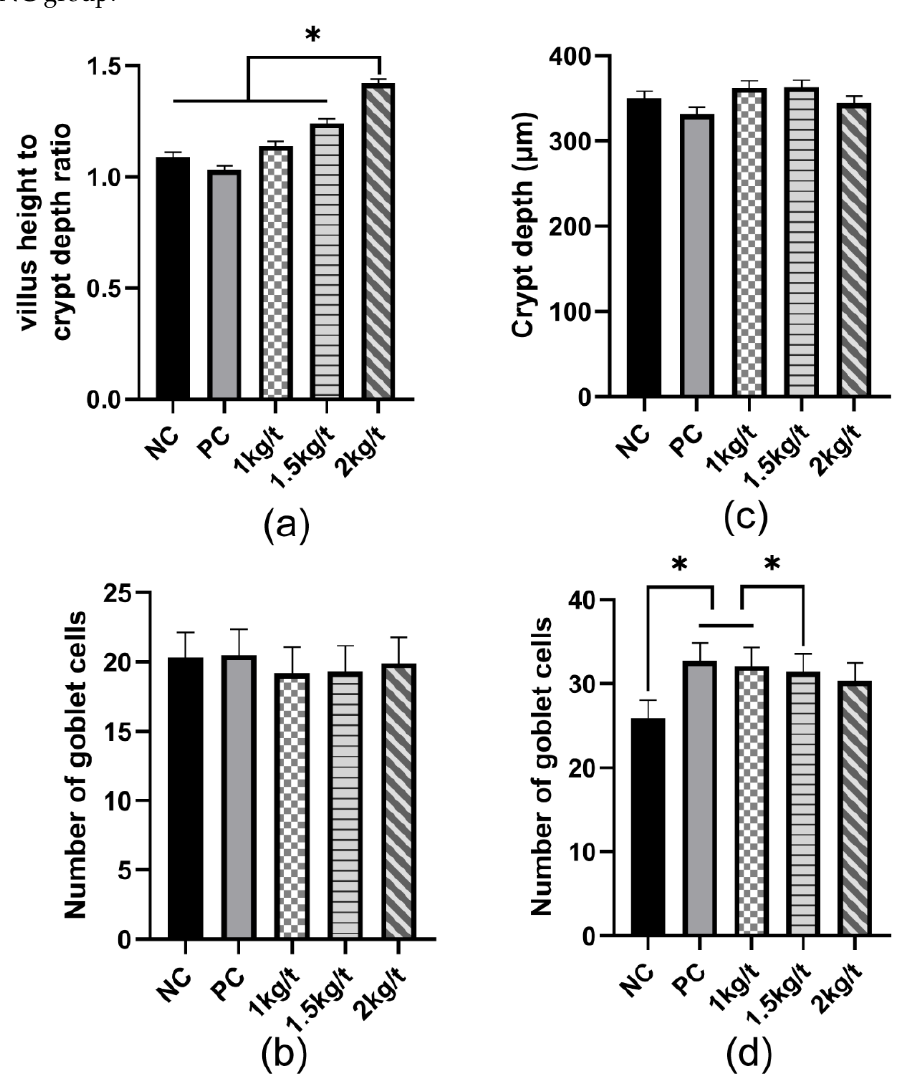
Figure 4. Effects of joint application of Lactobacillus plantarum and Bacillus subtilis on intestinal morphology and number of goblet cells in weaned piglets. ( a ) The ratio of villus height to crypt depth in the jejunum. ( b ) The number of jejunal goblet cells. ( c ) The depth of the colonic crypt. ( d ) The number of colonic goblet cells. “*” means there were statically significant differences ( p < 0.05). NC, a control diet; PC, NC + 150 ppm mucilage sulfate.